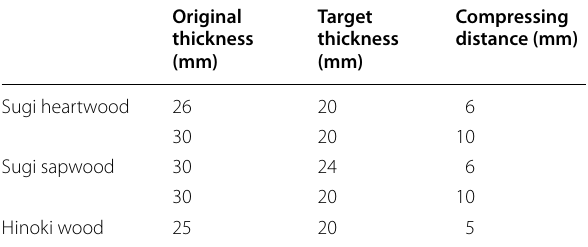
Table 1 Original and target thickness of timbers specimens